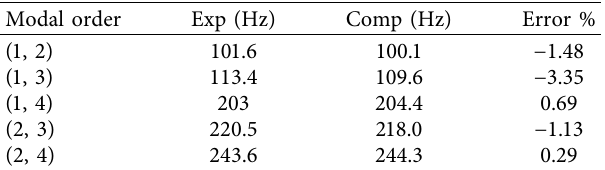
Table 4: Natural frequencies of bare cylindrical shells near free surface ( H �